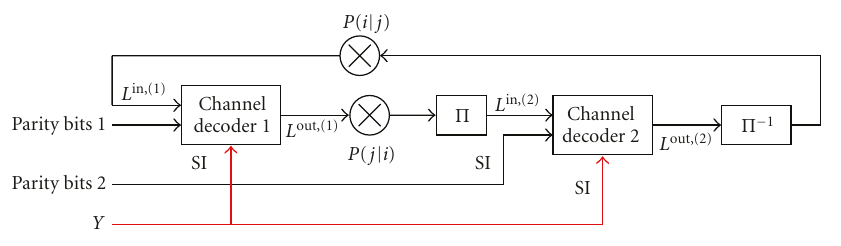
Figure 5: Channel cross-decoding of two descriptions with SI.